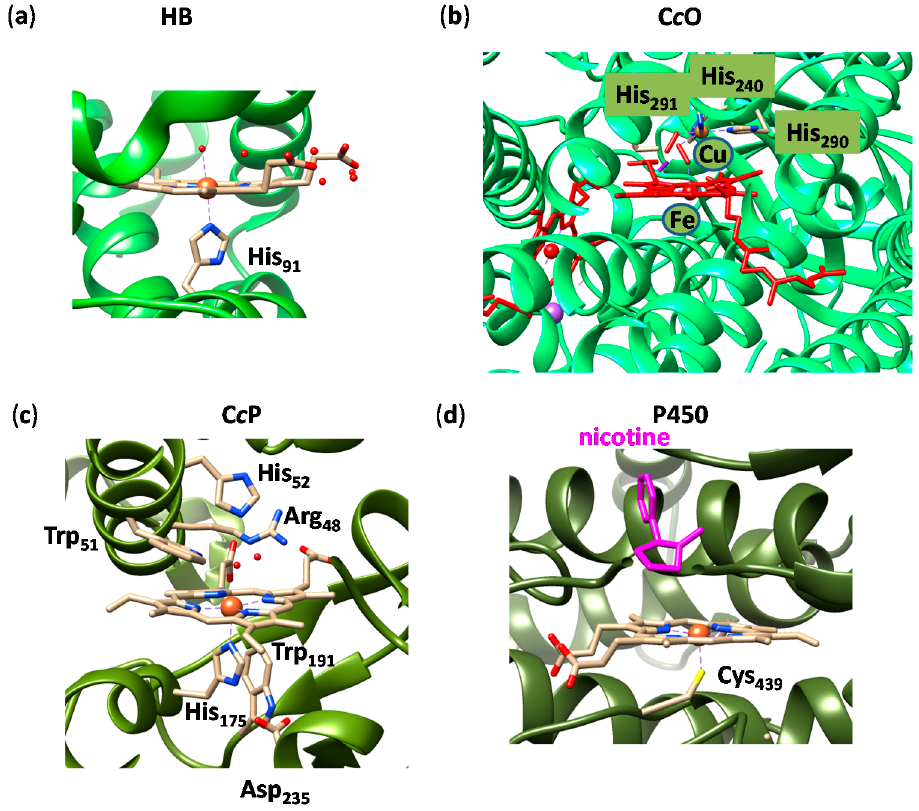
Figure 1. Active site structures of typical iron-heme enzymes. ( a ) hemoglobin (HB), 2QSP pdb (protein databank); ( b ) cytochrome c oxidase (C c O), 3WG7 pdb; ( c ) cytochrome c peroxidase (C c P), 4A6Z pdb; ( d ) cytochrome P450 with nicotine bound, 4EJG pdb. Colored ribbons represent the protein backbone. Key residues and substrate (nicotine) highlighted.